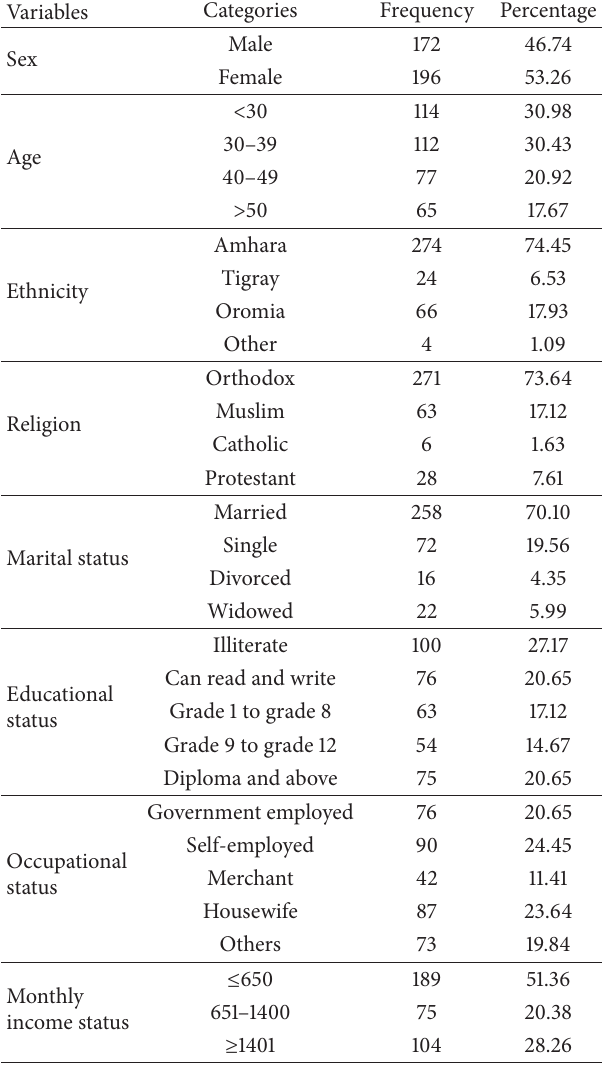
Table 2: WHO diagnostic criteria to know diabetes mellitus status of patients in Debre Berhan Referral Hospital in June